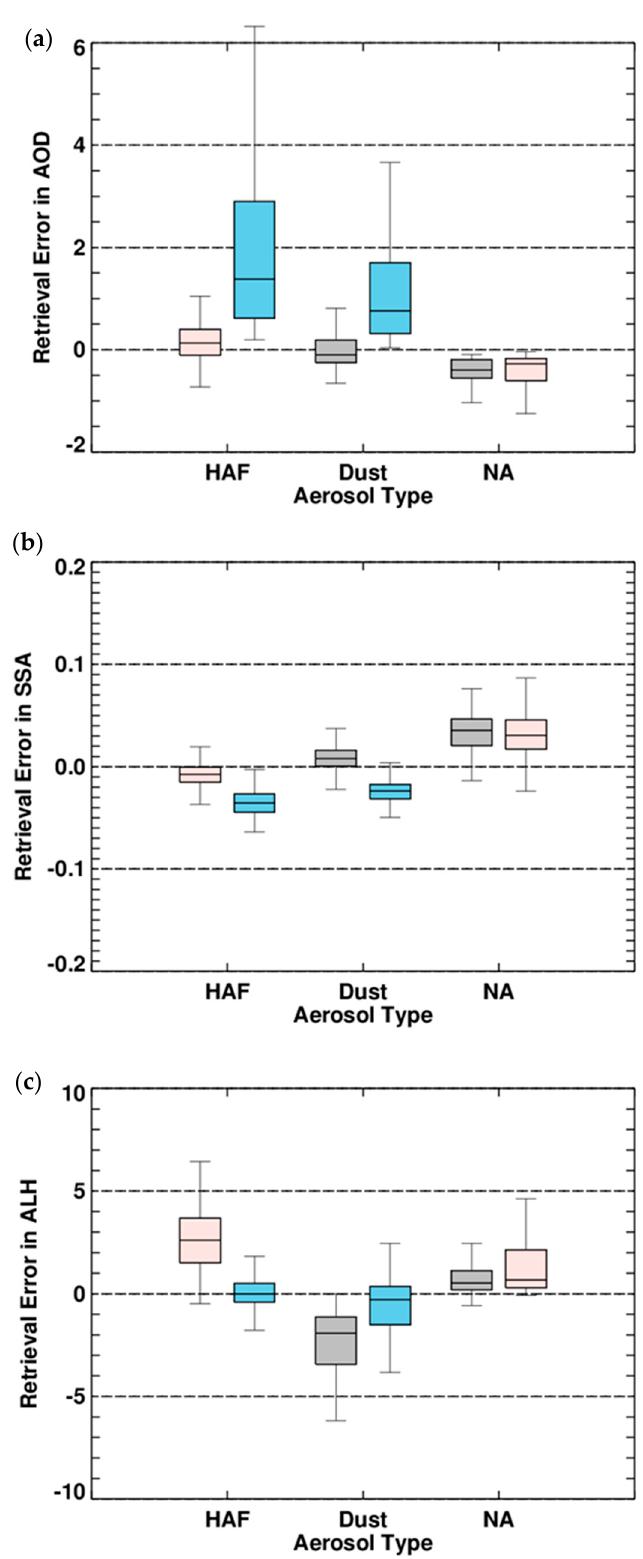
Figure 13. Retrieval error in ( a ) AOD, ( b ) SSA and ( c ) ALH (km) due to aerosol misclassification for each aerosol type. Box colors denote misclassified aerosol type under the conditions shown on the x -axis. Gray: HAF, pink: Dust and blue: NA Errors are obtained by testing the algorithm with an aerosol type that is different from the true condition. Each box-and-whisker plot for a true condition shows the retrieval error distribution derived from the 108-member ensemble for AOD and SSA and 81-member ensemble for ALH.